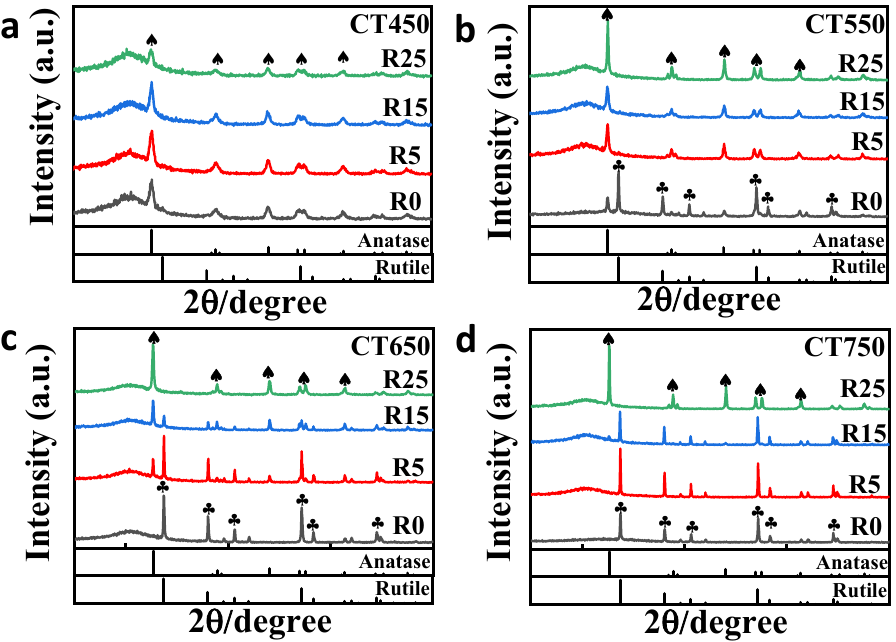
Figure 2. XRD patterns of TiO 2 obtained from precursors R0, R5, R15 and R25 after calcination at ( a ) 450 °C, ( b ) 550 °C, ( c ) 650 °C and ( d ) 750 °C.